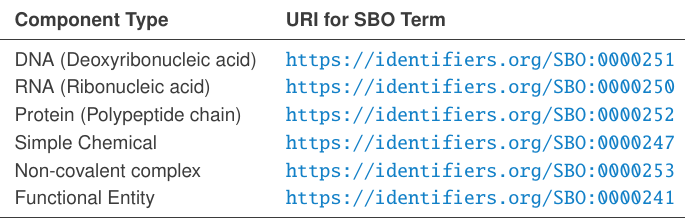
Table 2: Partial list of the most common SBO terms to specify the molecule type using the type property of a Component . Systems of multiple interacting molecules (e.g., a plasmid expressing a protein) should use the functional entity type.